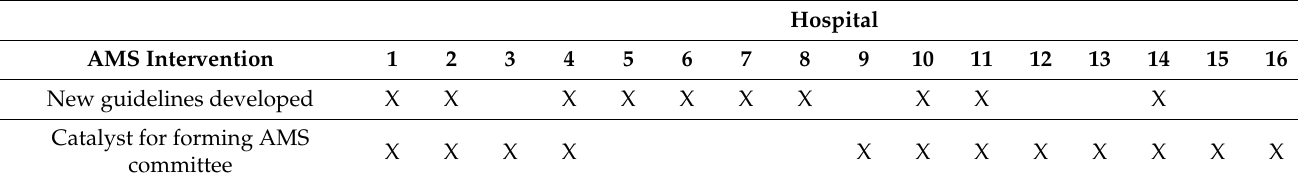
Table 7. AMS interventions at 16 of the 17 hospitals in response to the PPS carried